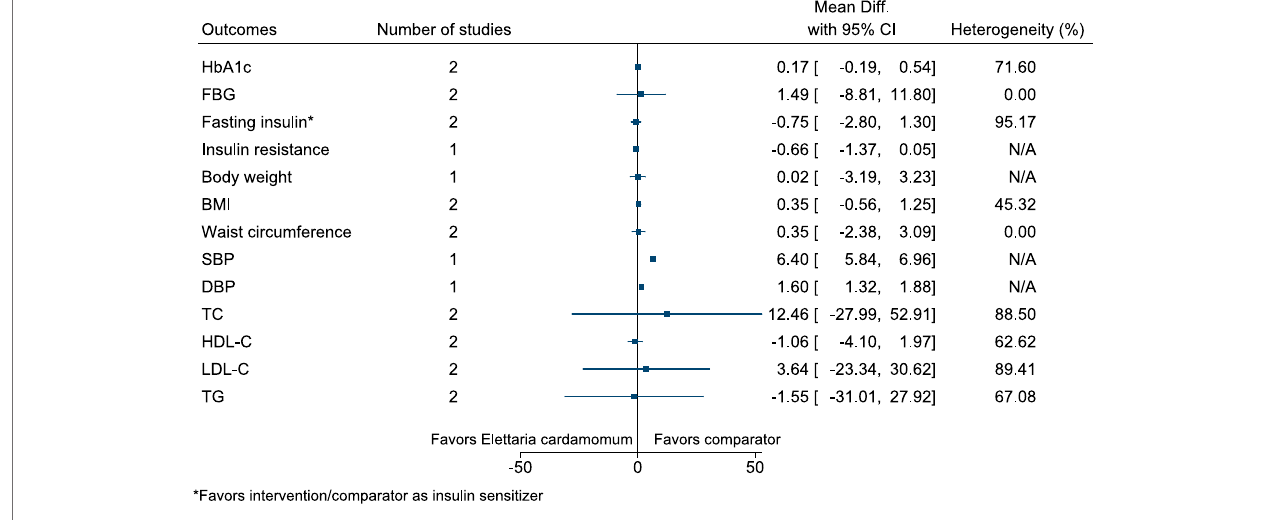
FIGURE 17 | Elettaria cardamomum - Summary forest plot.